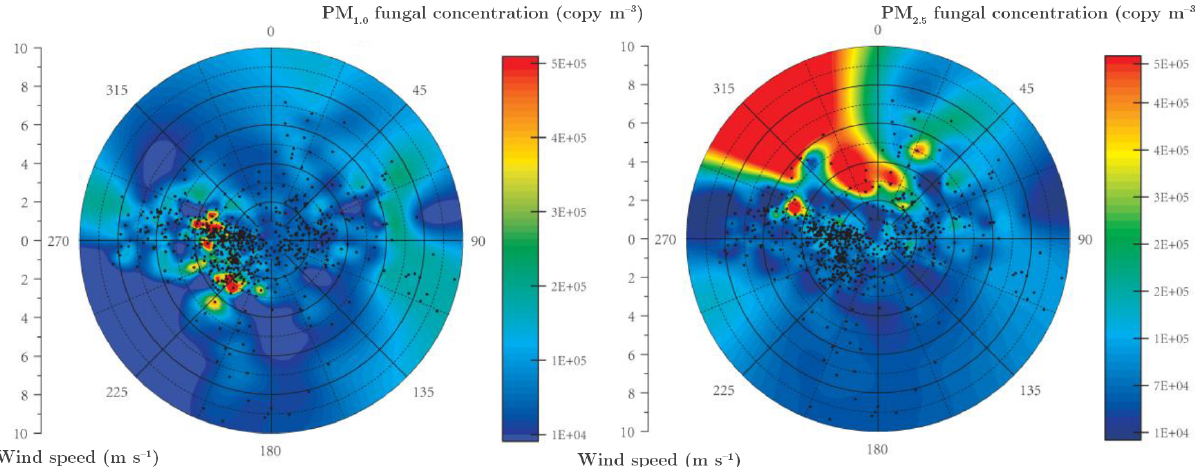
Figure 1. Relationships between fungal number concentrations of PM 2 . 5 and PM 1 with wind speed and wind direction.